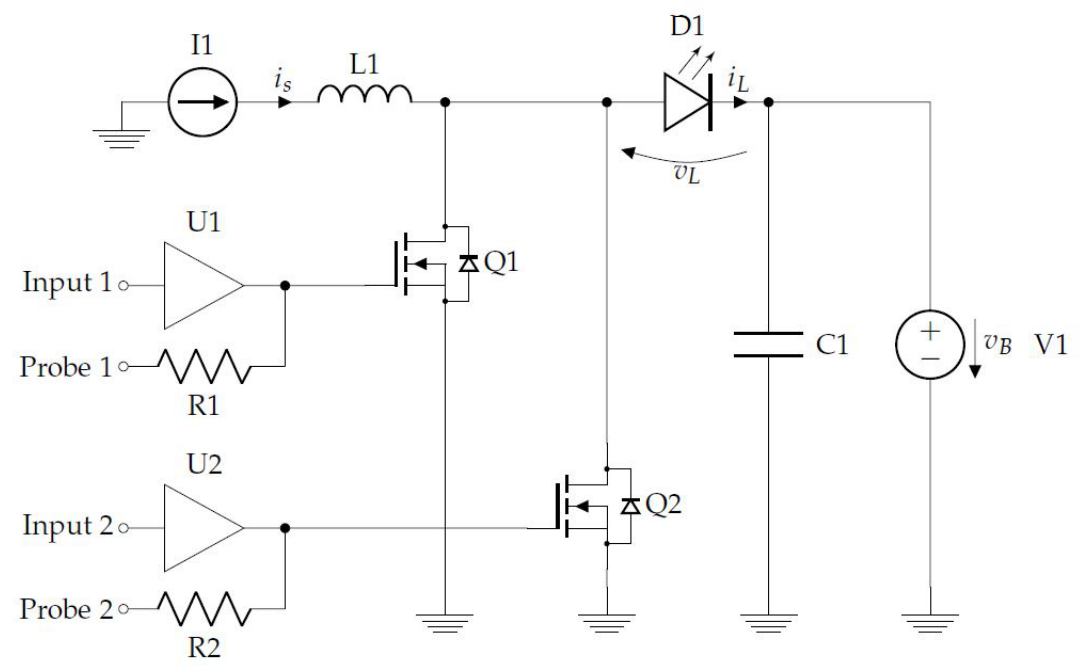
Figure 4. Seed laser pulse driver